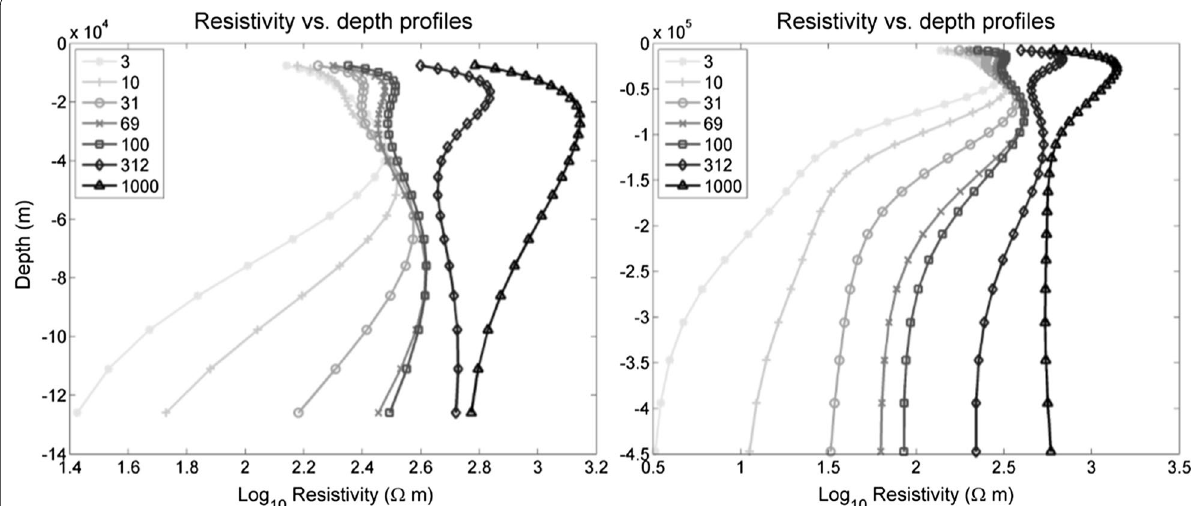
Fig. 8 The averaged resistivity values taken from the inversions with different resistivities for the prior model ranging from 3 to 1000 (cid:31) m, for depths of 10 to 140 km (left) and 10 to 450 km